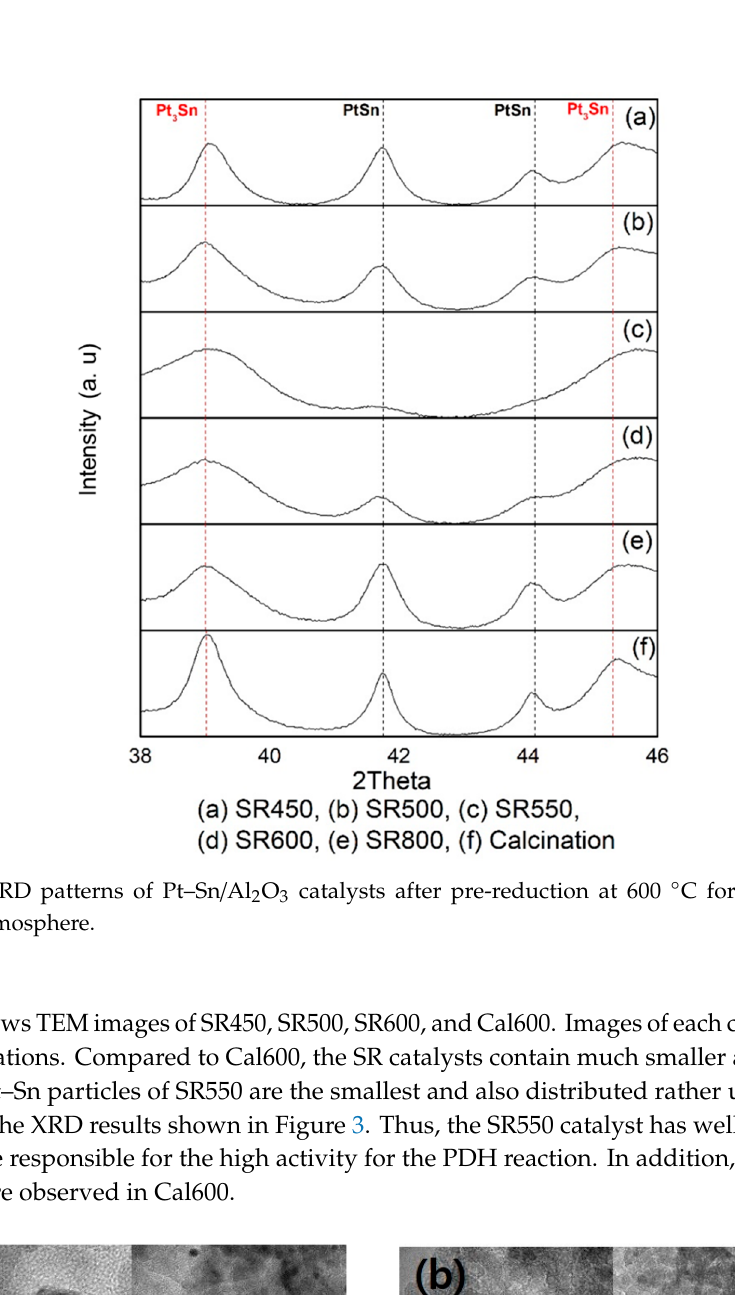
Figure 3. XRD patterns of Pt–Sn/Al 2 O 3 catalysts after catalyst preparation.